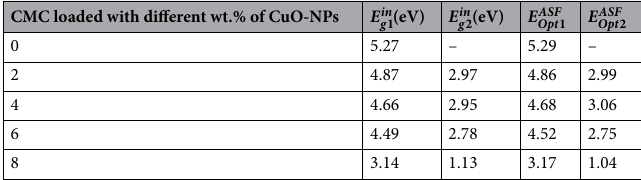
CMC loaded with different wt.% of